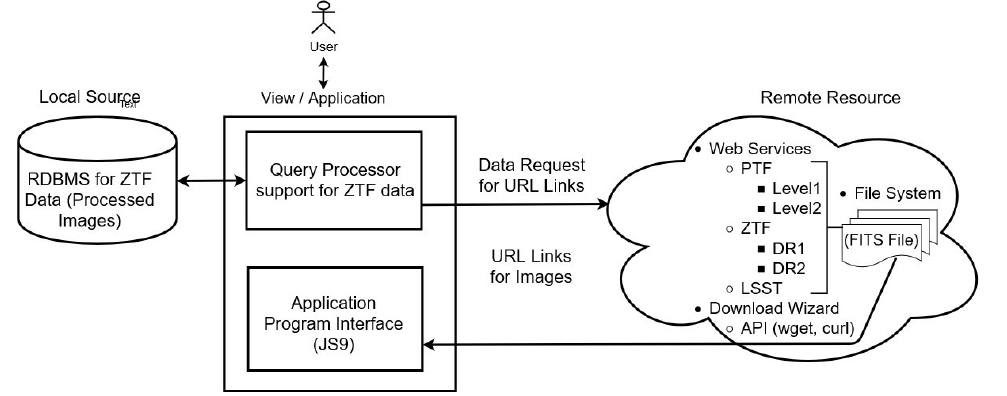
Figure 6. Proposed Web-Based Polystore System